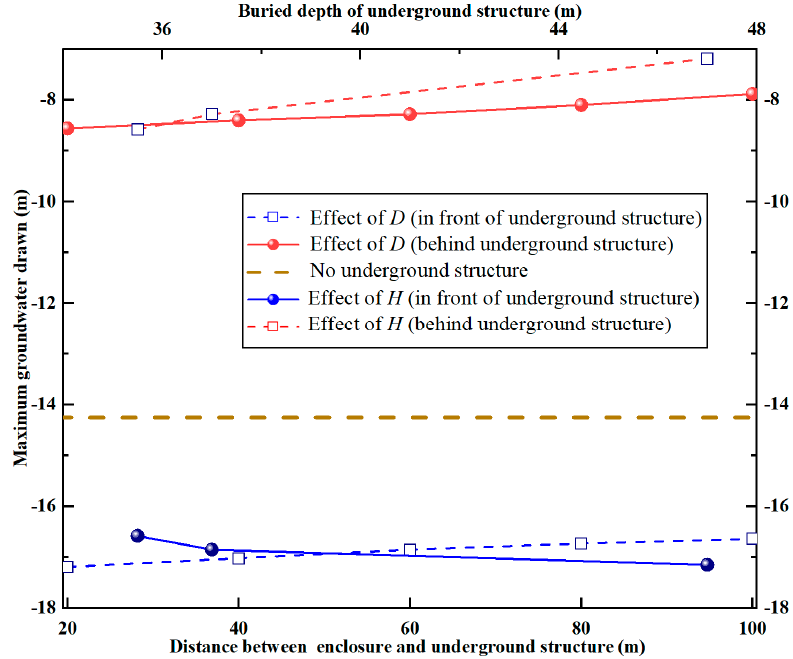
Figure 11. Influence of D and H on maximum groundwater drawdown.